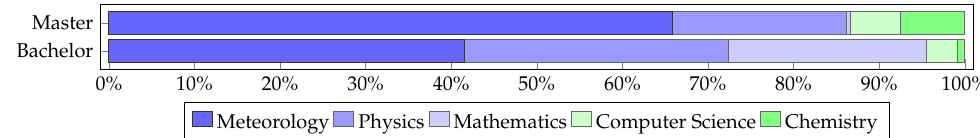
Figure 6. Curricular analysis of 17 Bachelor and Master meteorology